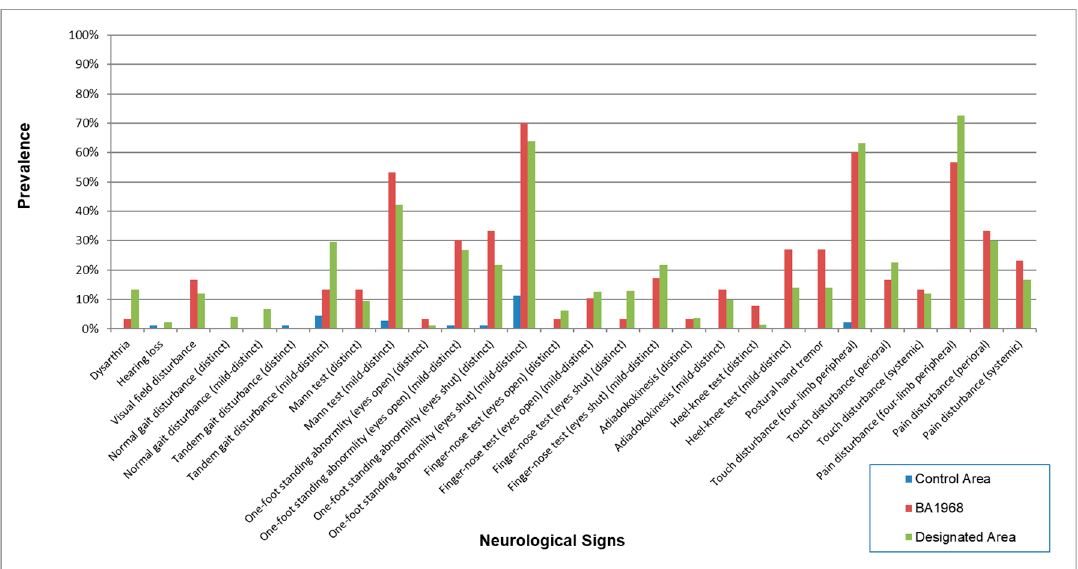
Figure 13. Prevalence of neurological signs in the younger generation. Prevalence in BA1968 and the Designated Area were higher than in the Control Area. The patterns of signs in BA1968 and the Designated Area were similar. Table 16. Score of signs and symptoms in younger subjects.